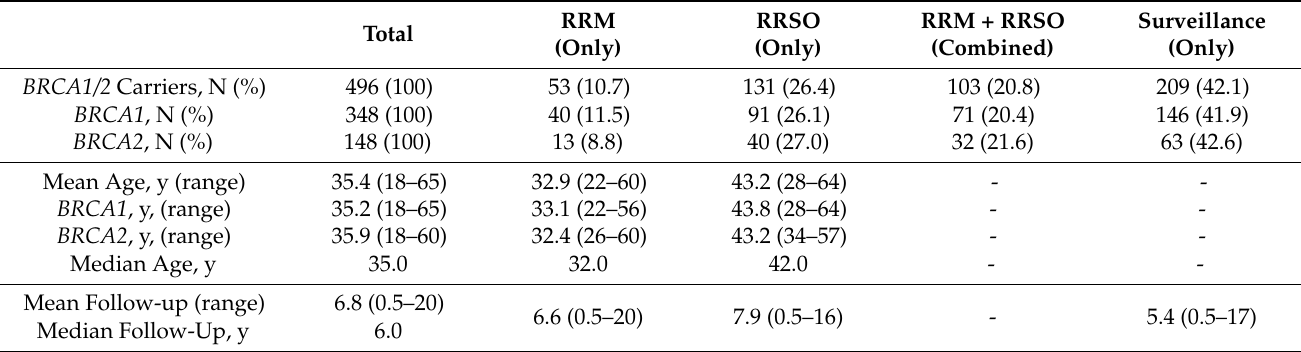
Table 1. BRCA1/2 Carriers Surveillance Data and Prophylactic Procedures (RRM, RRSO, Combination of RRM and RRSO). Total